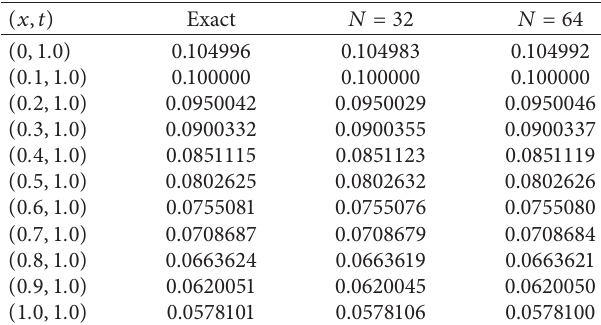
Table 1: Numerical results for Example 1 using two different values � 1 . 0and μ � 0 . 1. of N when T 0